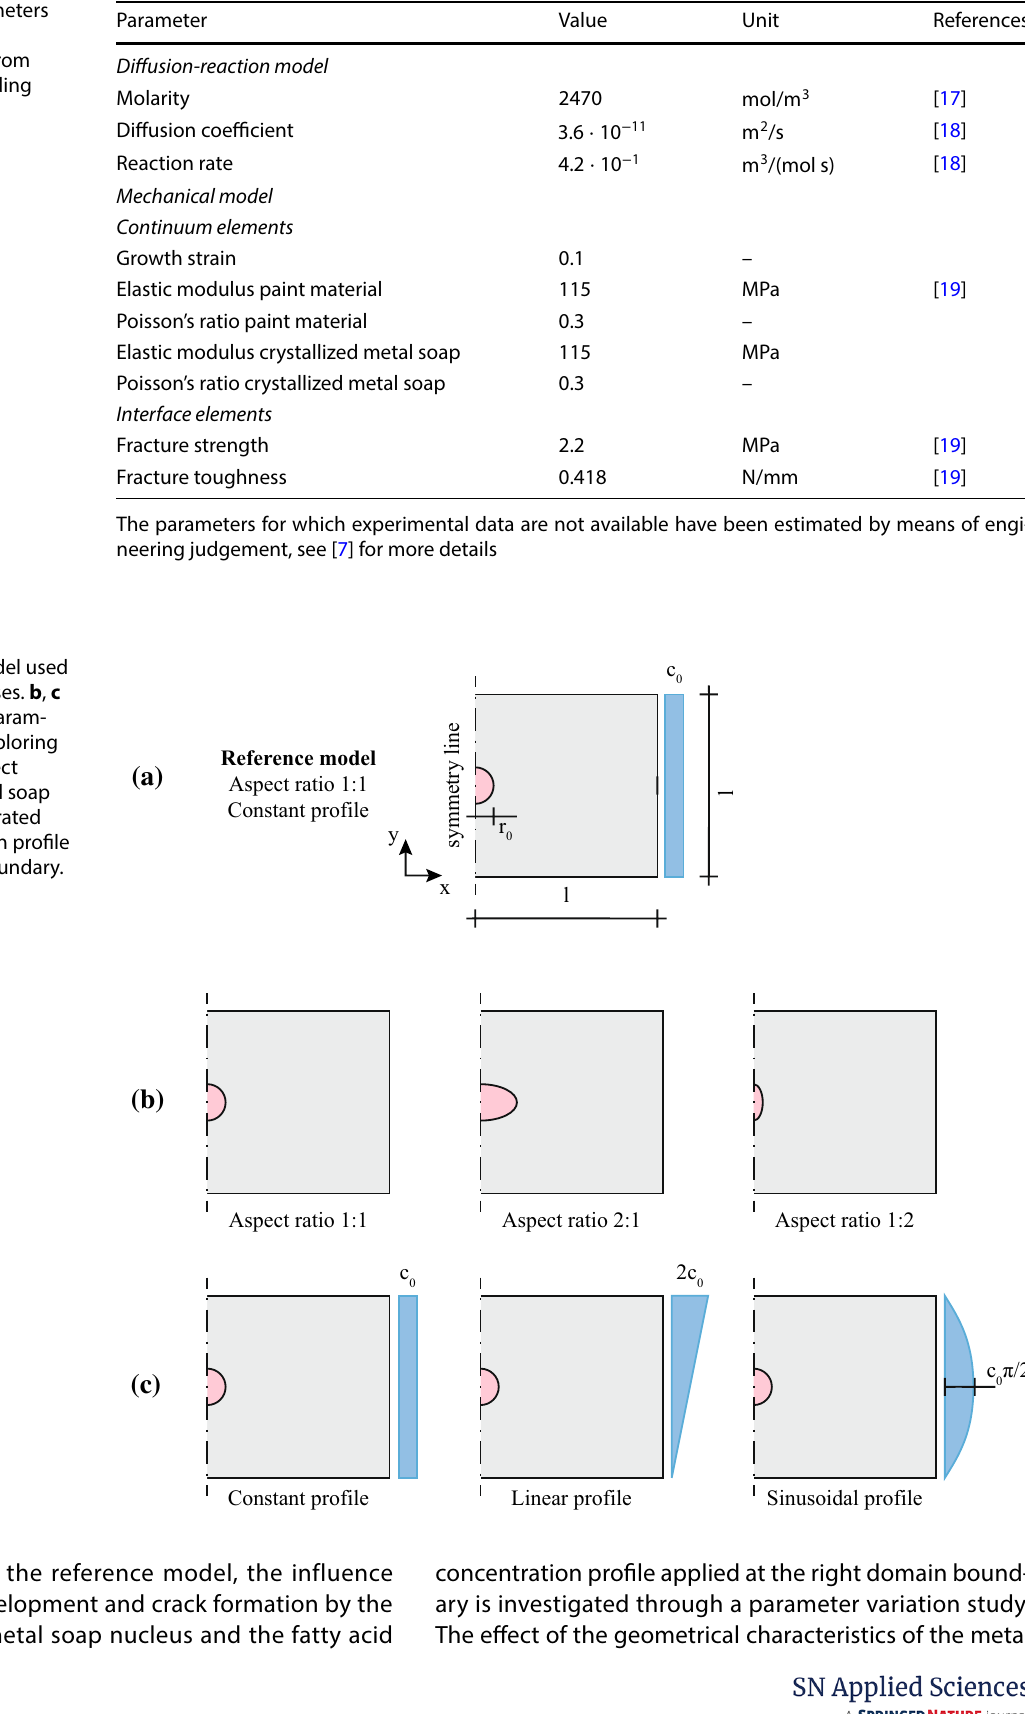
Table 2 Material parameters used in the numerical simulations, adopted from [7], and the corresponding